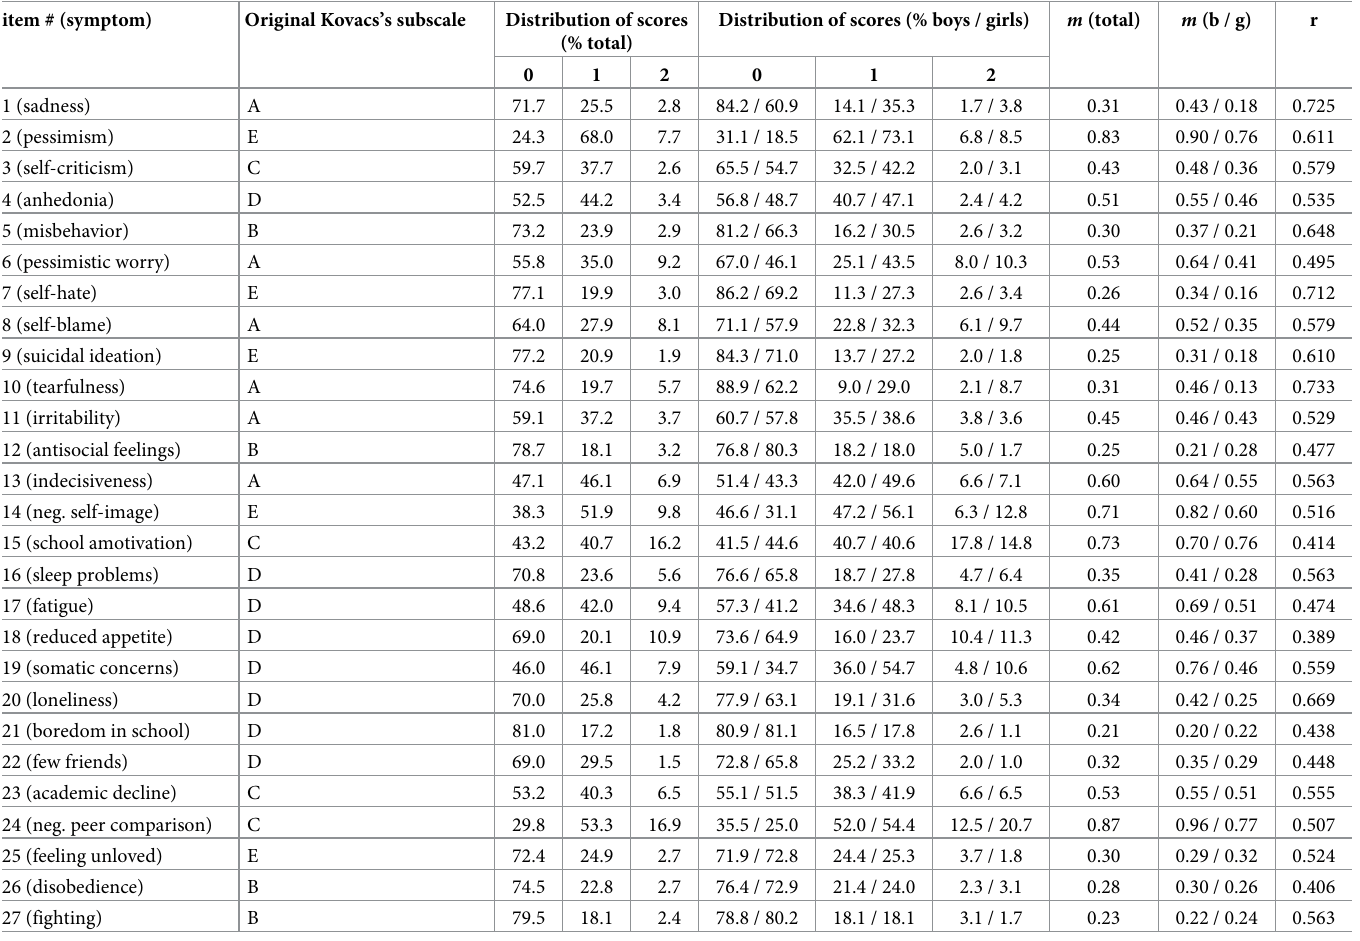
Table 2. Descriptive statistics of the individual CDI